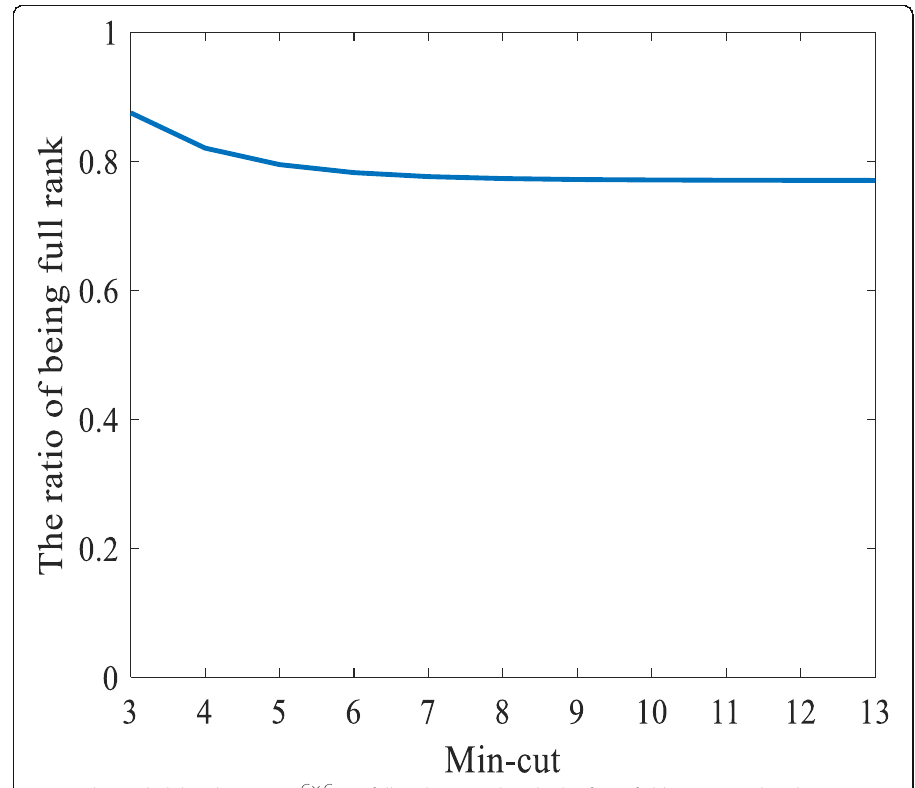
Fig. 5 The probability that T ∈ ( F 2 ) C × C is a full rank. Legend: Only the finite field F 2 is